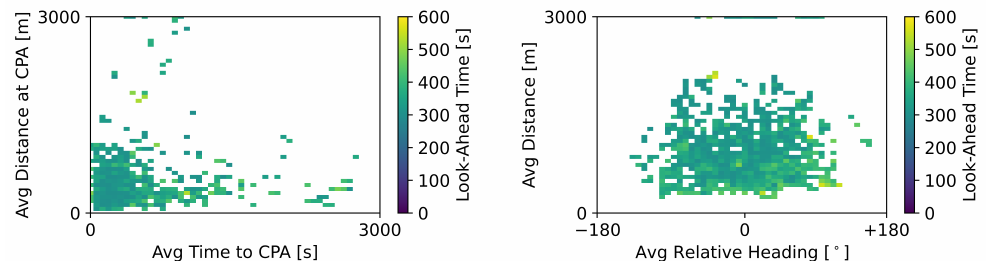
Figure 7. Situations in which the RL + MVP defended against surrounding aircraft, but the baseline MVP method did not.